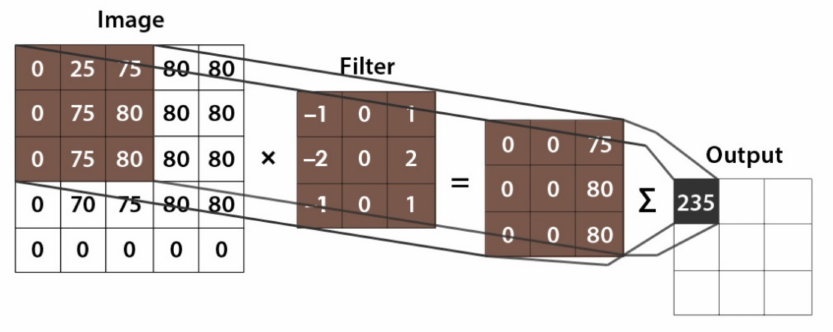
Figure 8. Representation of the convolution operation.